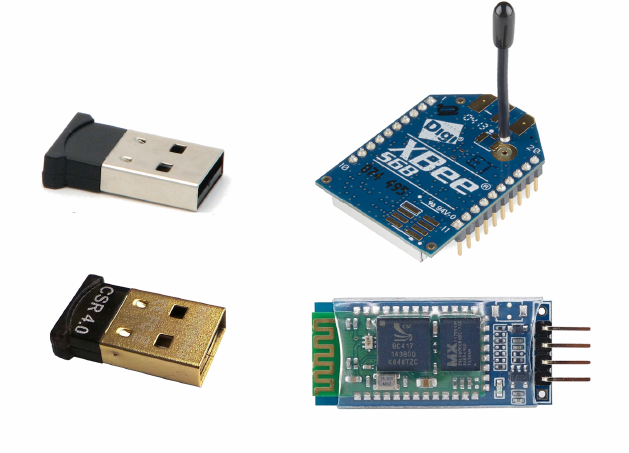
Figure 19. Example of some communication